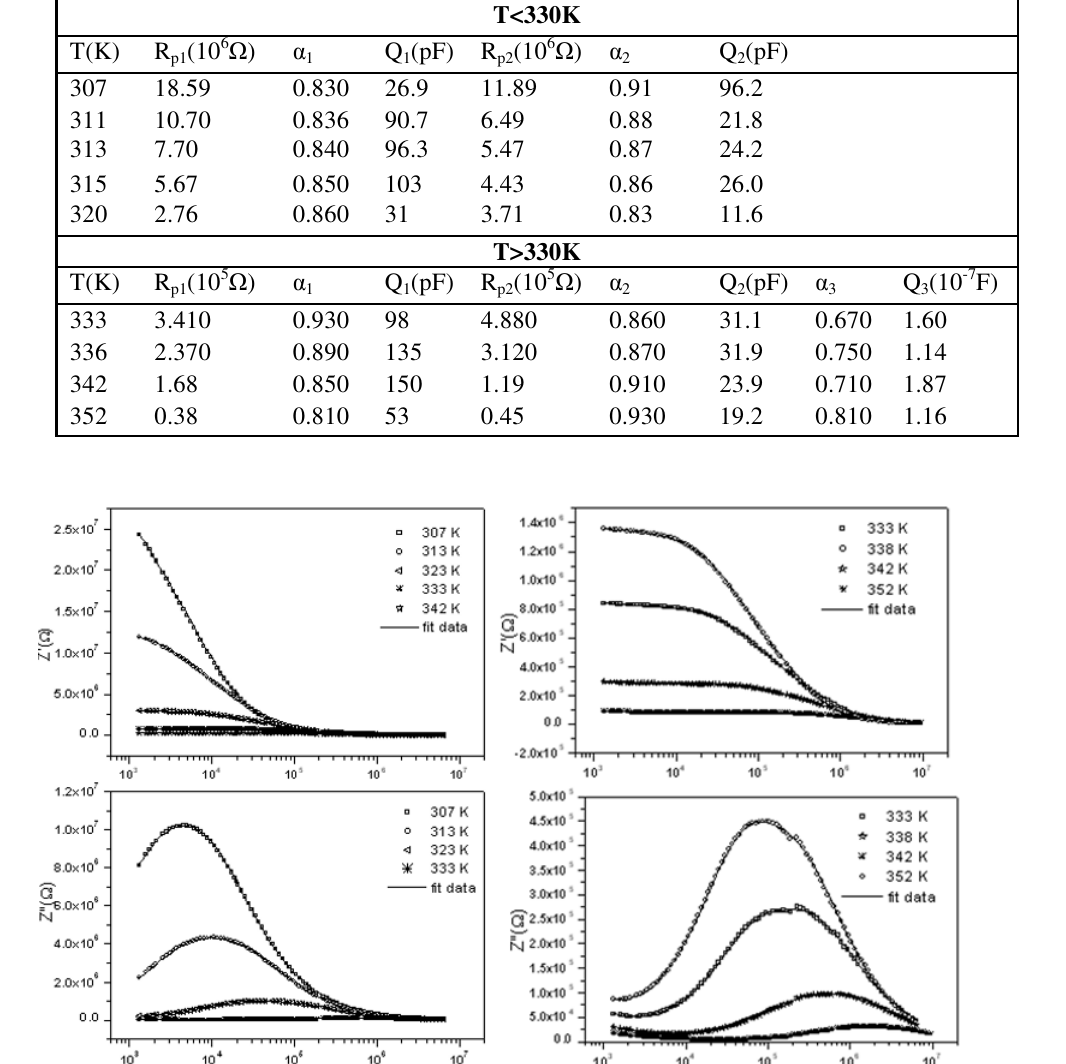
Table 3. Temperature dependence of Rp, Q, and the fractional exponent α .